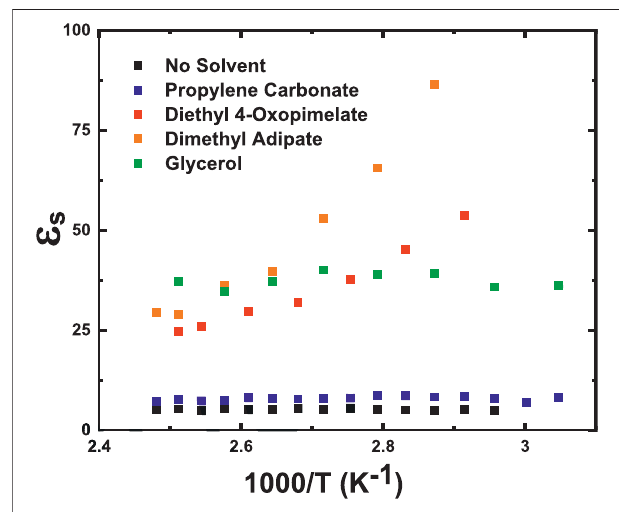
FIGURE 6 | Static dielectric constant as a function of temperature for membranes solvated with propylene carbonate, glycerol, dimethyl adipate, and diethyl 4-oxopimelate obtained from fi ts to the electrode polarization